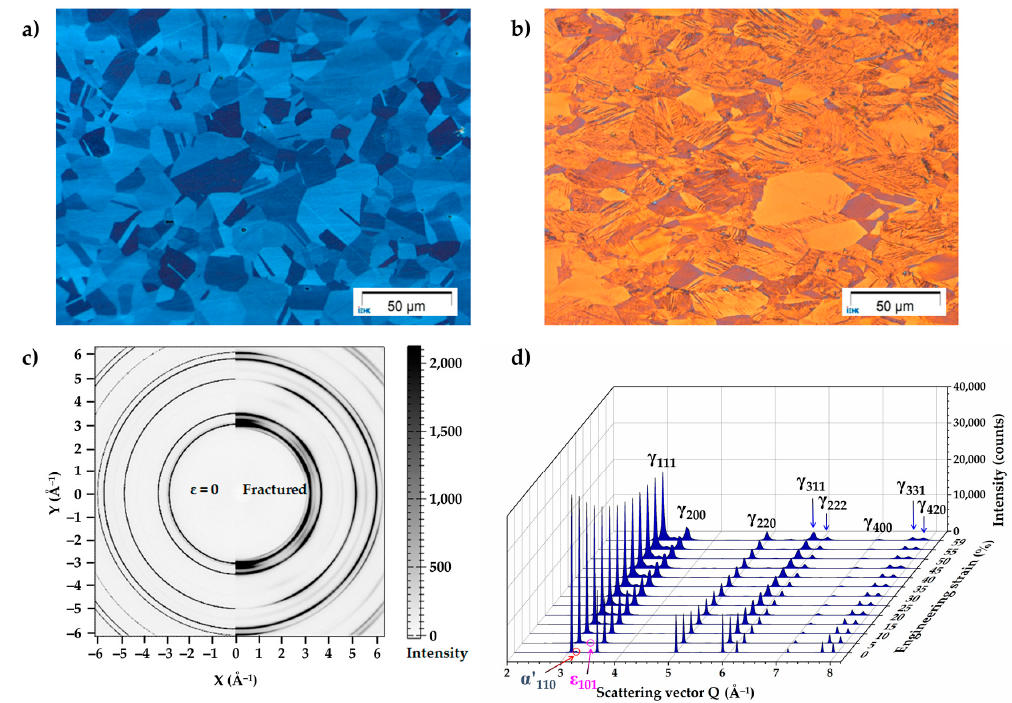
Figure 4. ( a ) Microstructure of the Fe-17Mn-1.5Al-0.3C steel before tensile test [4]; ( b ) microstructure of the steel after tensile test [4]; ( c ) two-dimensional diffraction pattern from the steel before and after the tensile test; and ( d ) the SYXRD profiles of the integrated intensities at different engineering strain levels.